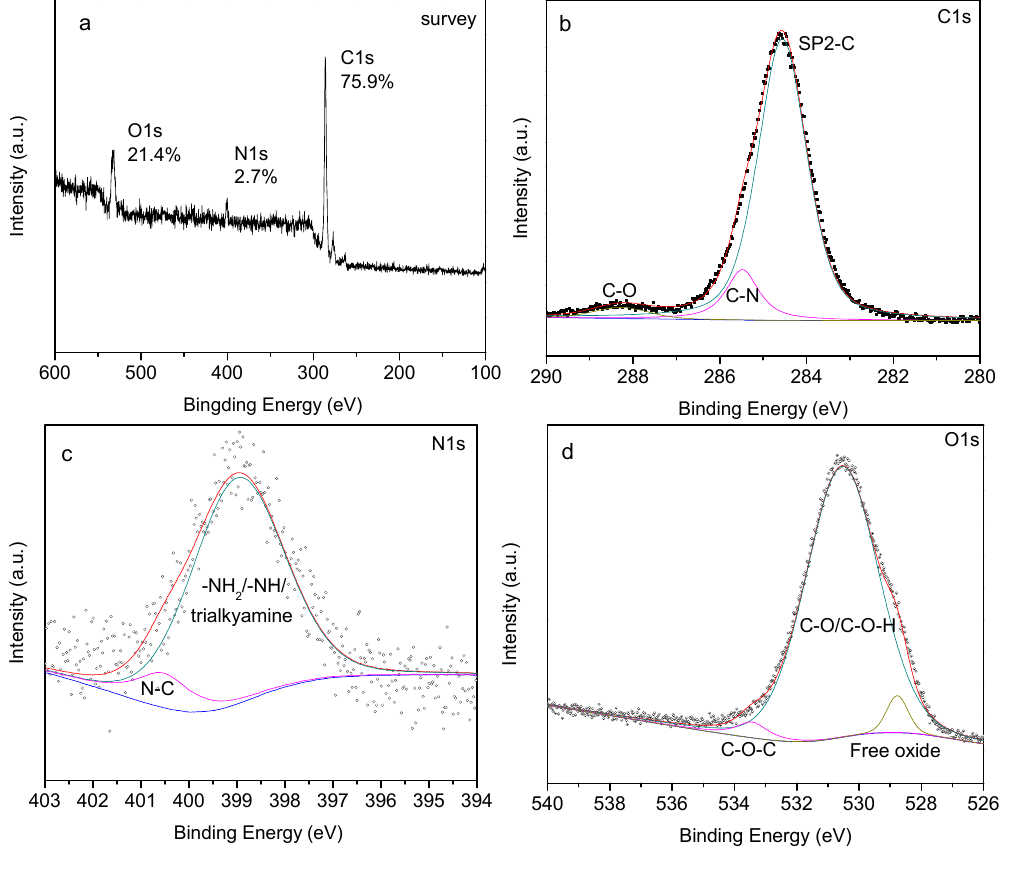
Figure 7. XP spectra of EDA/MBDGA cross ‐ linked MWCNTs ( a ) survey; ( b ) C1s region; ( c ) N1s region; and ( d ) O1s region.